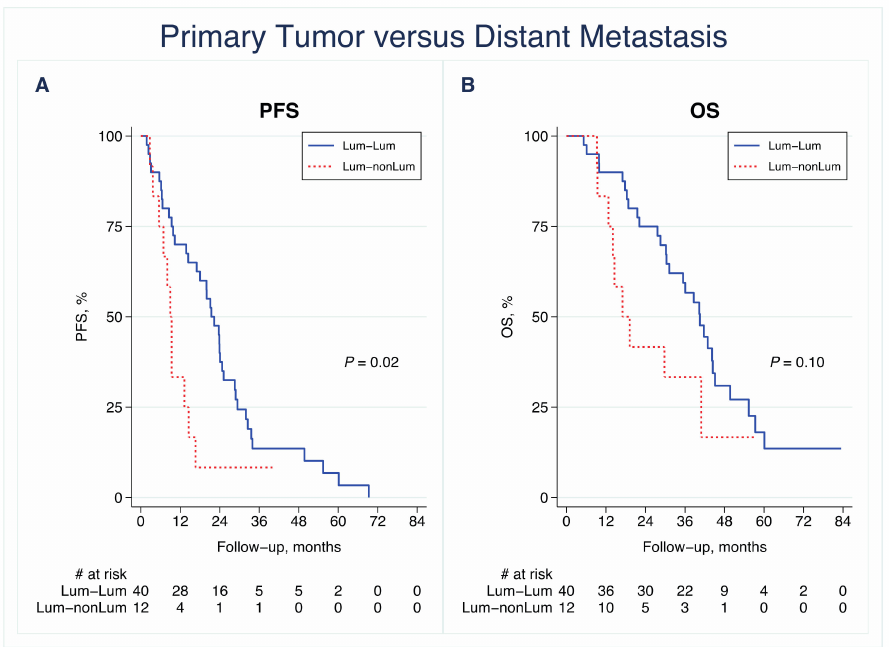
Figure 4. Kaplan–Meier survival curves for ( A ) progression-free survival (PFS) and ( B ) overall survival (OS) in relation to subgroups of patients with shifts between luminal (luminal A or B (Lum)) and non-luminal (HER2-E or basal-like (nonLum)) subtypes from the primary tumor to distant metastasis. p -values were calculated using the log-rank